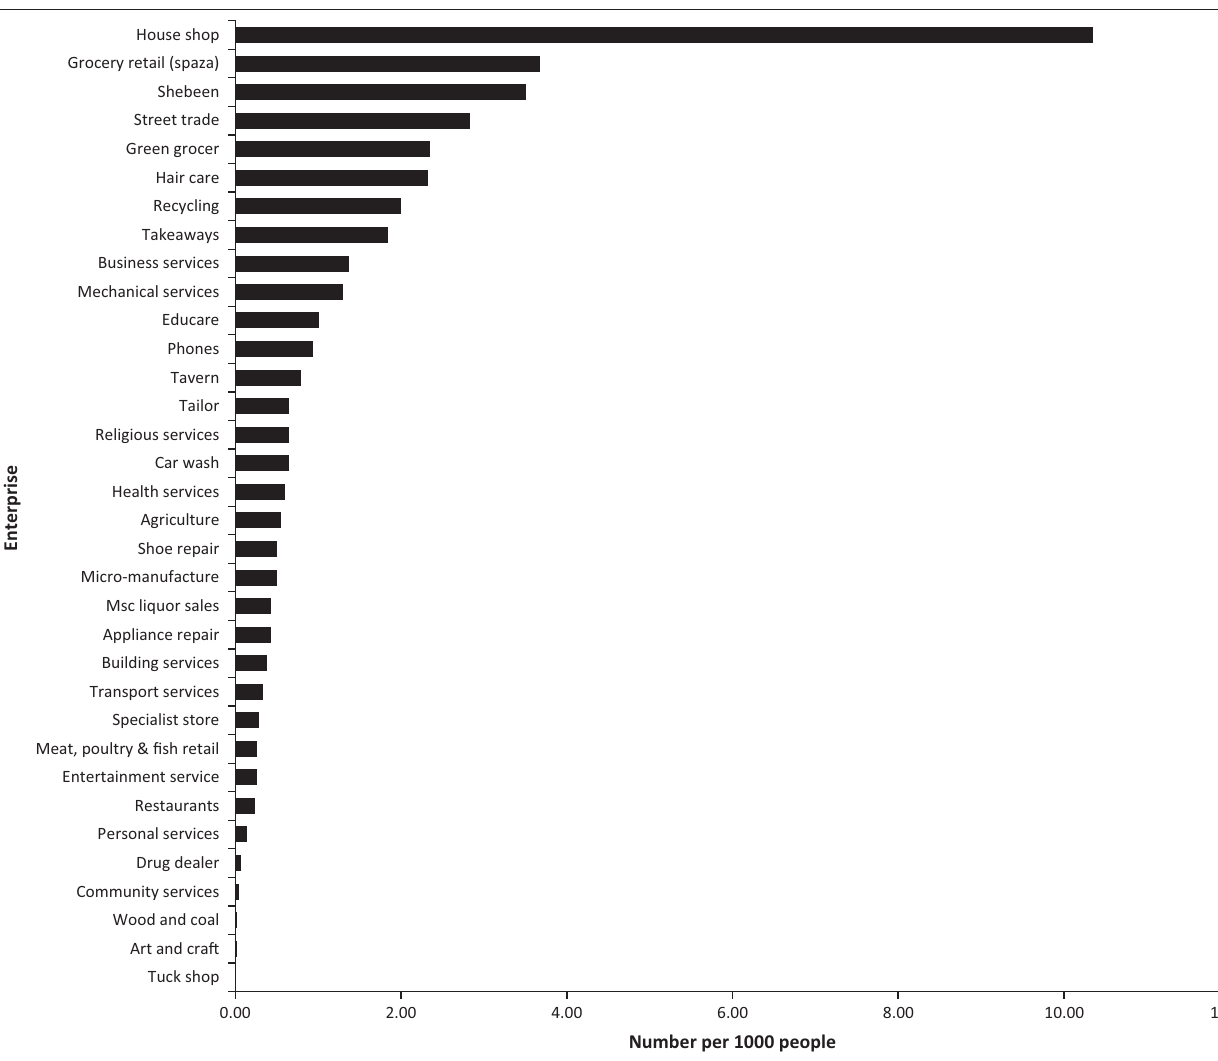
FIGURE 2: Tembisa, enterprise activities per 1000